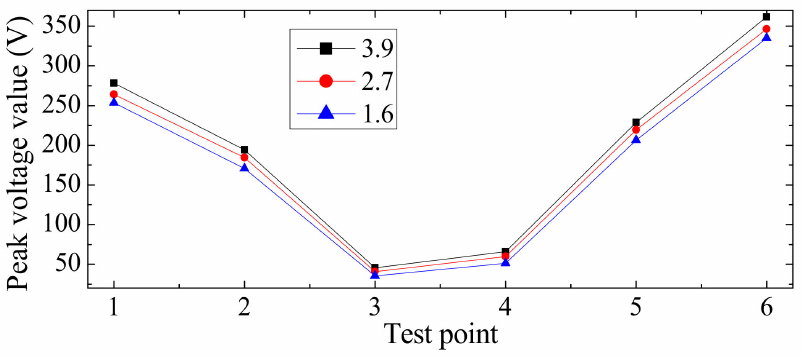
Figure 21. Peak interlayer voltage under different relative permittivity (tr = 200 ns, C-type). The results of comparative interlayer voltage simulation under different winding structures are shown in Figure 22. In most of the test points, the peak voltage drops in Z- type winding are very different from C-type winding. The reason can be found in Figure 18.